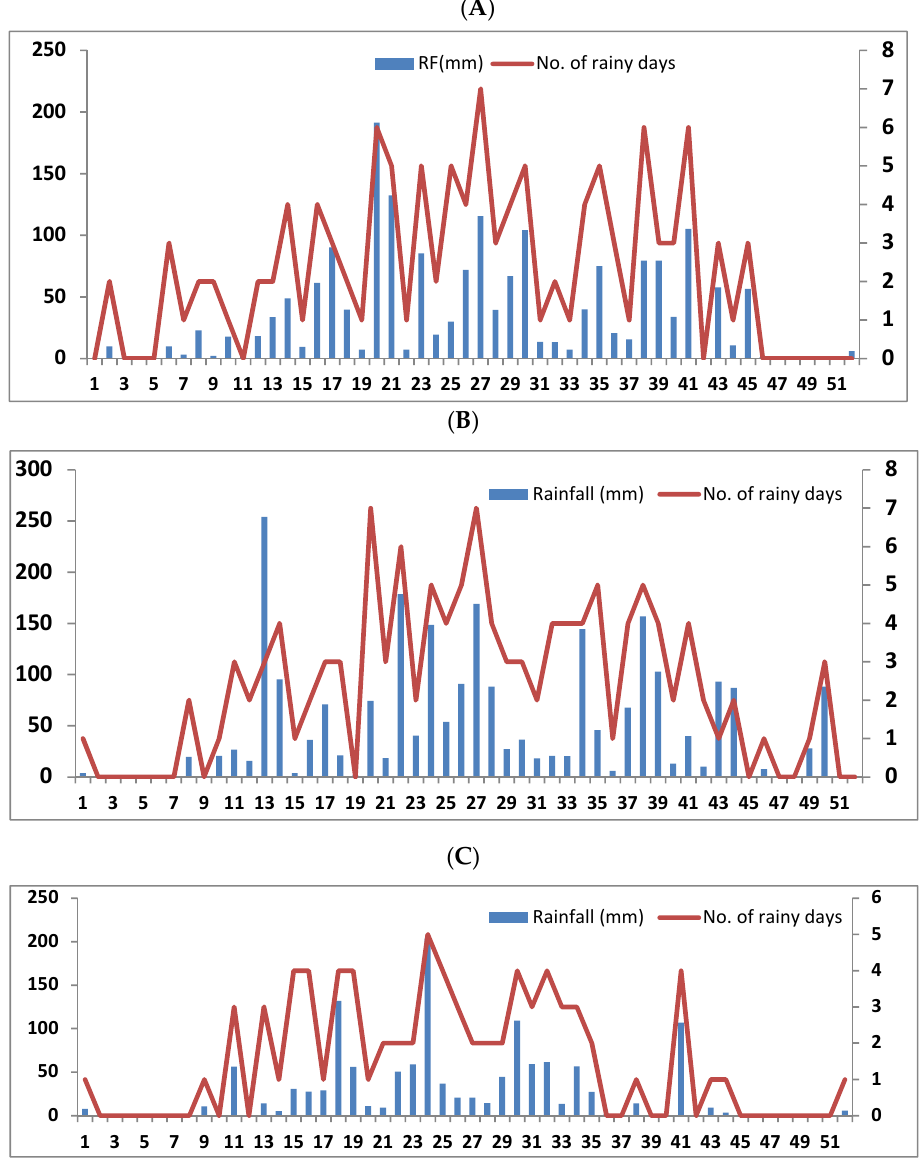
Figure3. Rainfall(RF)distributionduring( A )2016, ( B )2017, and( C Figure 3. Rainfall (RF) distribution during ( A ) 2016, ( B ) 2017, and ( C ) 2018 in Manipur in standard weeks.